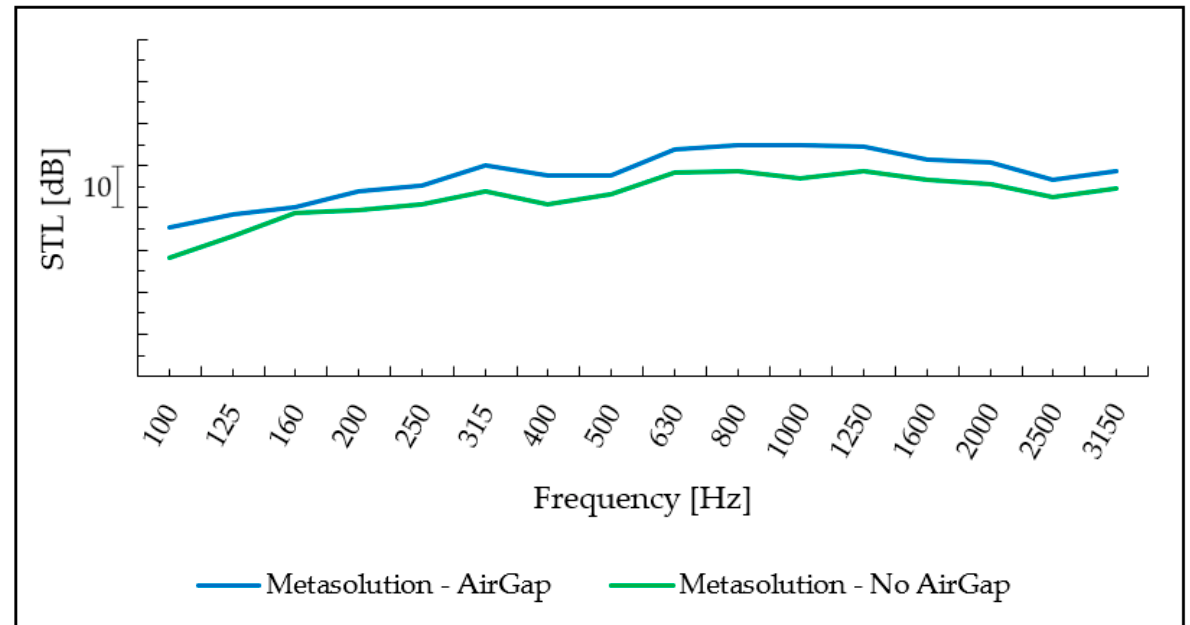
Figure 13. Experimental results for the Metasolution tested with different air gaps.